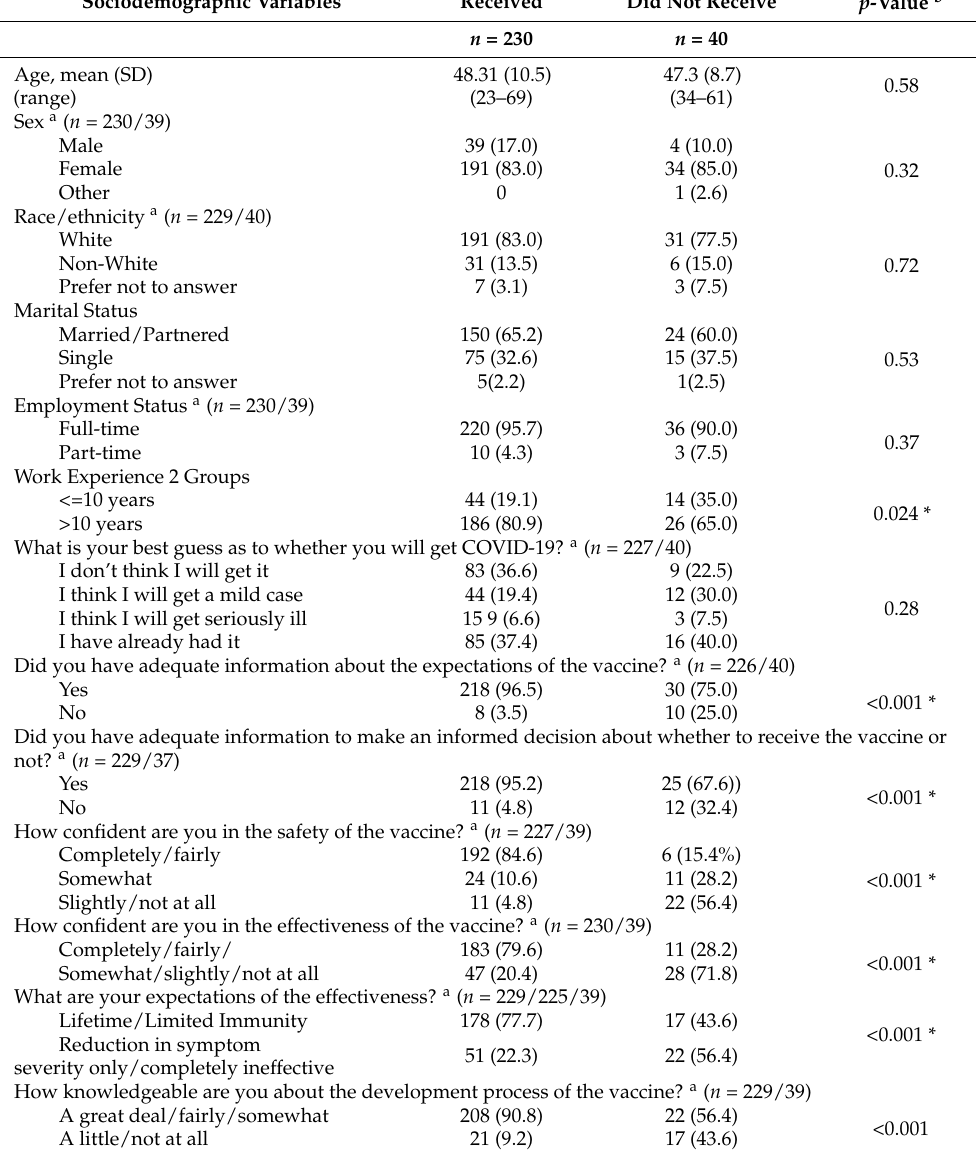
Table 3. Sociodemographic and COVID-19 Vaccine Variables by Vaccine